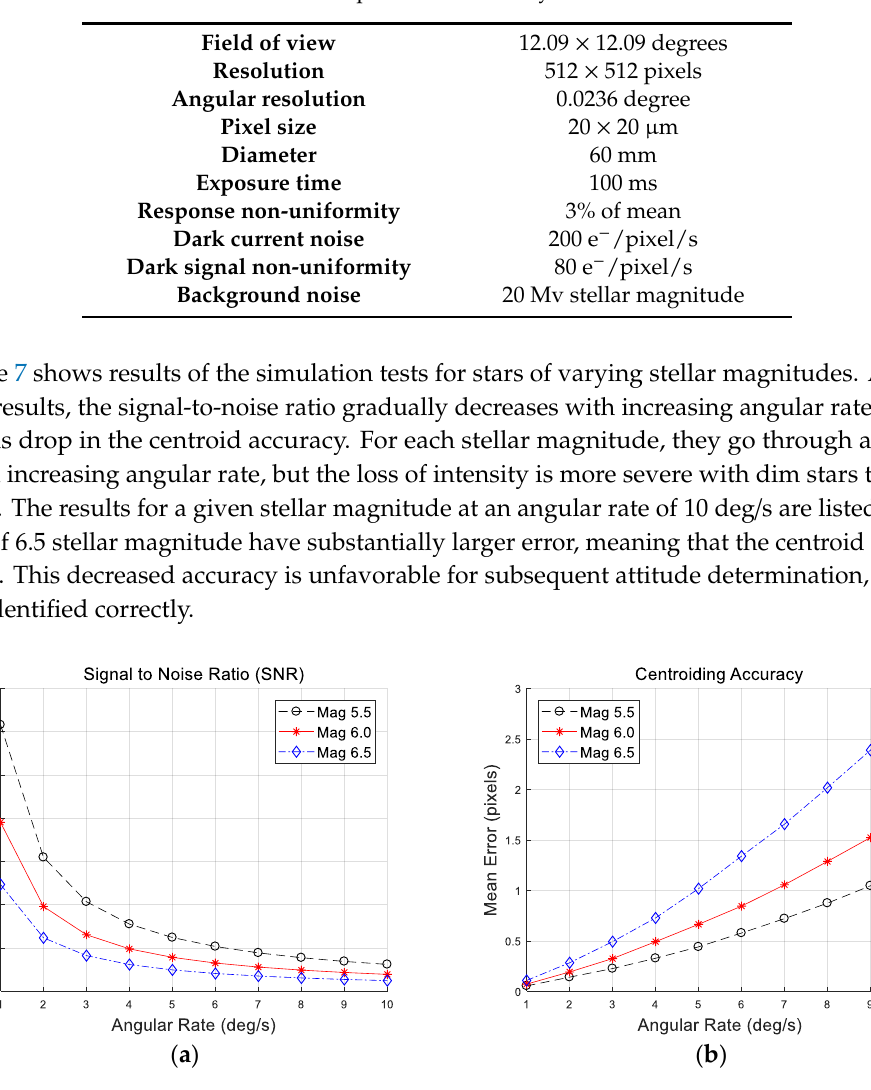
Figure 7. ( a ) Signal-to-noise ratio; ( b ) mean error of a centroid as a function of rates. Table 5. Centroid accuracy and signal-to-noise ratio at 10 deg/s angular rate.